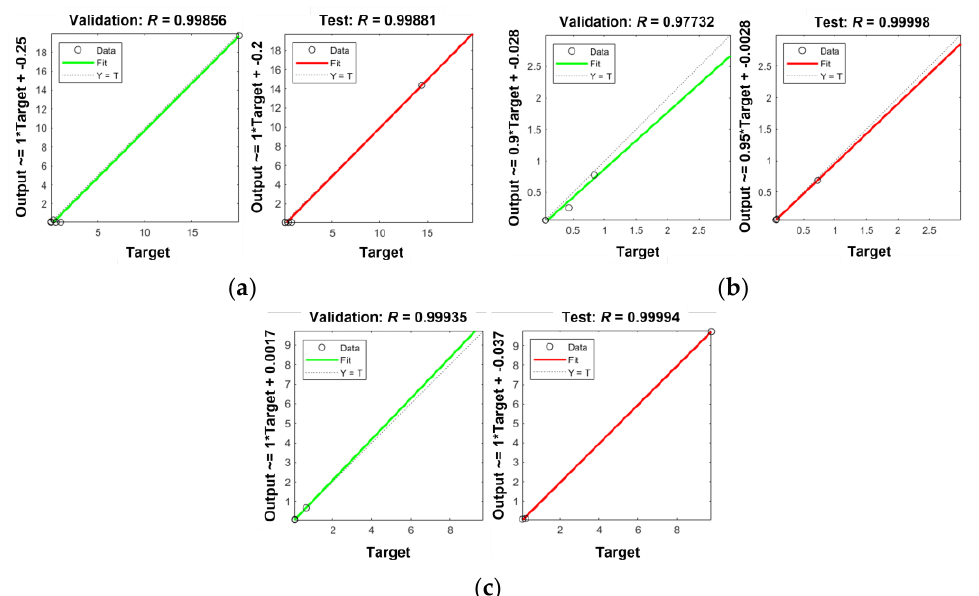
Figure A9. Correlation plots for NN-PSO simulations of HI (adults) for ( a ) TW, ( b ) GW, and ( c ) WRS.